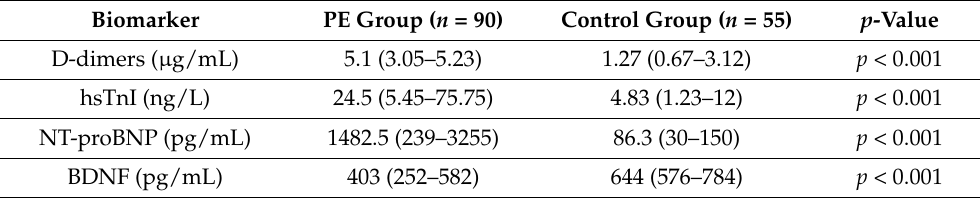
Table 3. Biomarker profiles in the study